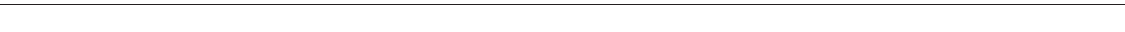
Fig. 4 Control of mammalian cell fate by the assembly of apoptosis regulatory proteins on synthetic RNA scaffolds. a AFM images of 1, 3, 6, 9 and 14Kt-33-Tri RNA nanostructures in the presence of L7Ae. Scale bars , 10 nm. b , c Microscopic images ( b ) and fl ow cytometric analysis ( c ) of cells that contain RNA nanostructures and L7Ae-dCasp-8-coding modRNA. Scale bars , 500 µ m. The cells were stained with Paci fi c Blue Annexin V and dead cell stain, and were analysed using fl ow cytometry. d Plots of the dead cell population versus the number of Kt (rcKt) motifs. Dead cells were counted by considering Paci fi c Blue-positive cells to be dead. e Selective cell death by a speci fi c RNP interaction between 14Kt-33-Tri and L7Ae-dCasp-8 (or L7Ae- Casp-8). RNA nanostructures and modRNAs were co-transfected into HeLa cells. Cells stained with Paci fi c Blue Annexin V were counted as dead cells. f Caspase fl uorometric assay for the detection of caspase activity. The caspase activity of HeLa cells transfected with RNA devices and modRNAs was measured using a fl uorogenic substrate IETD-AMC. IETD-FMK was used as a caspase inhibitor. The data are presented as the mean ± SD ( n = 3). ** P < 0.01, *** P < 0.001 (Welch ’ s t